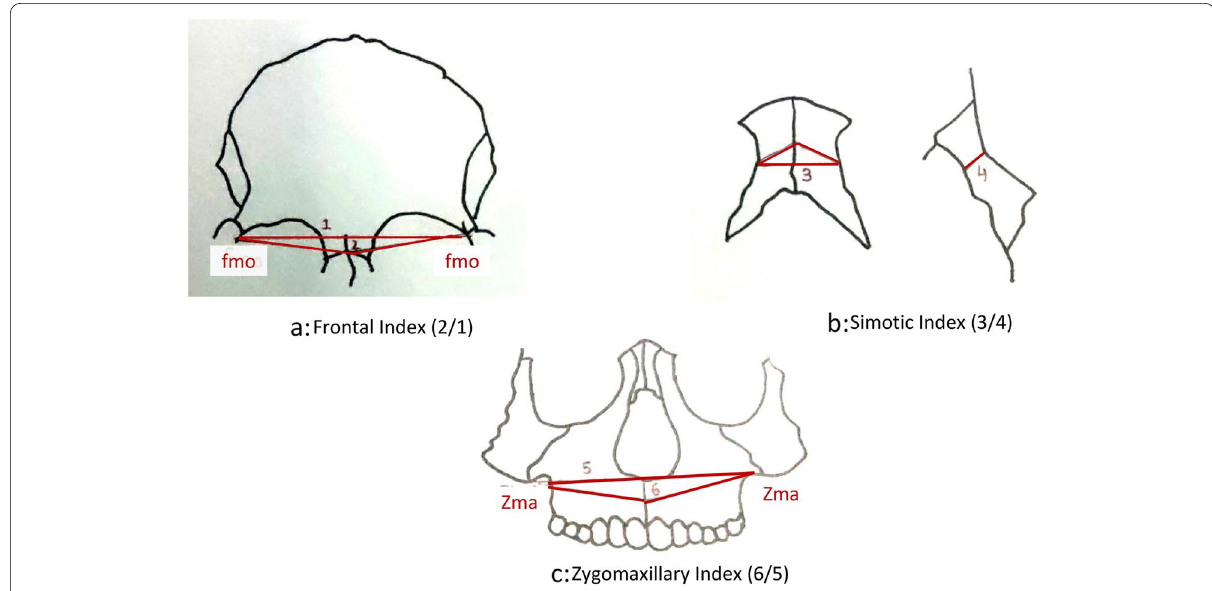
Fig. 3 Indices of facial flatness (Chalala et al. 2019). a Frontal index (2/1). b Simotic Index (3/4). c Zygomaxillary Index